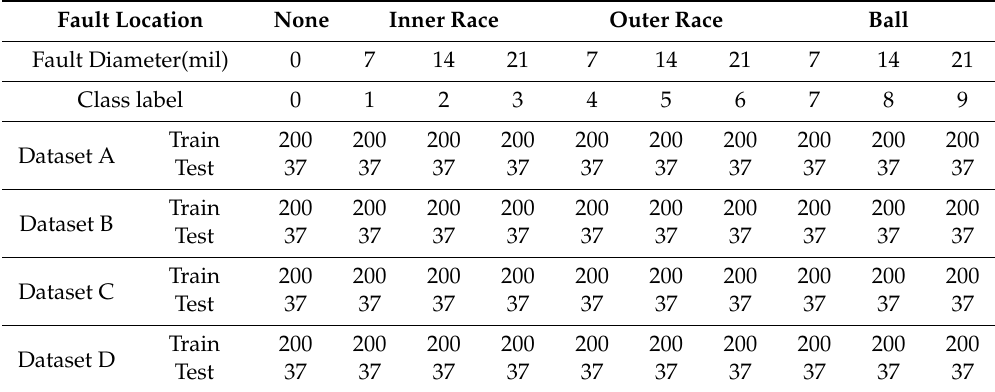
Figure 6. Vibration signals of bearing under 2-hp loads from one sensor. ( a – c ) are the bearing inner race fault signal under fault size of 7mils, 14mils and 21 mils, respectively. ( b – d ) are the bearing outer race fault under fault size of 7 mils, the 14 mils and 21 mils, respectively. ( g – i ) are the bearing ball fault under size of 7 mils, 14 mils and 21 mils, respectively. ( j ) the normal bearing signal.